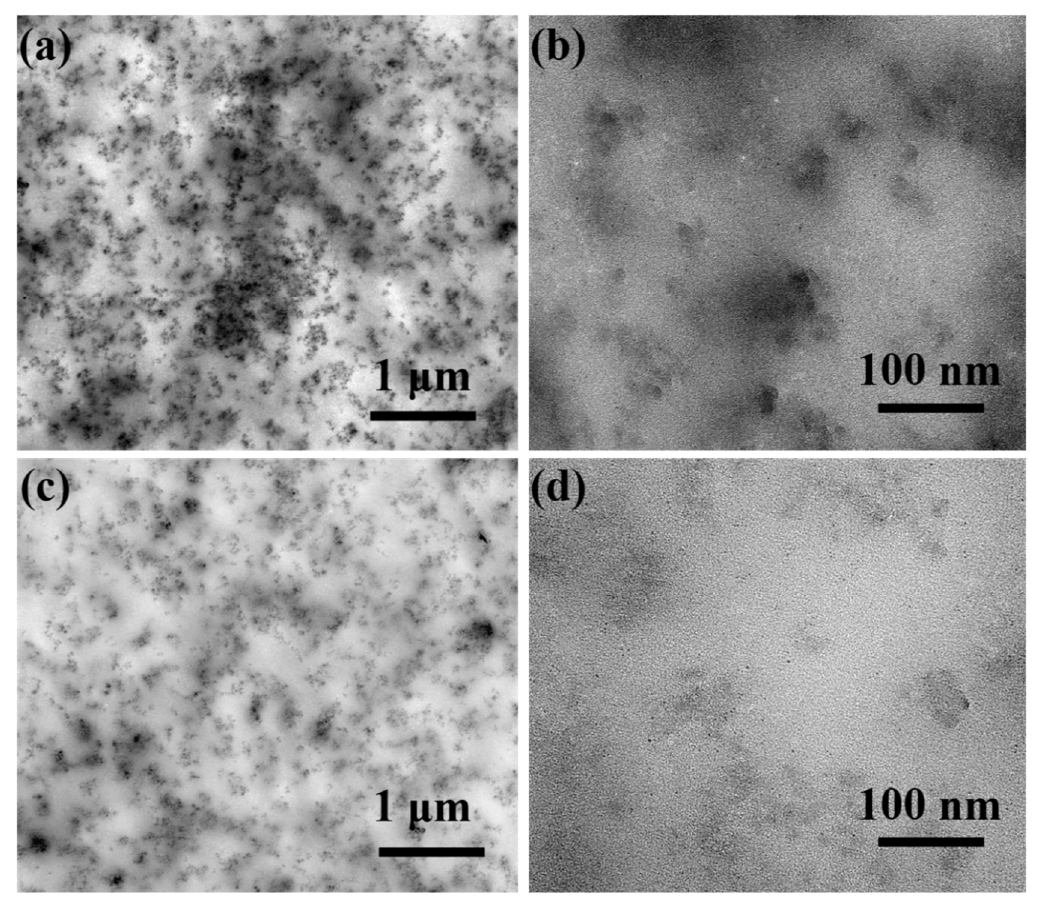
Figure 6. TEM morphologies of ( a , b ) the SiO 2 /SR and ( c , d ) the f -SiO 2 /SR composites at 10 wt.% filler content. Table 3. Thermal stability of f -SiO 2 /SR